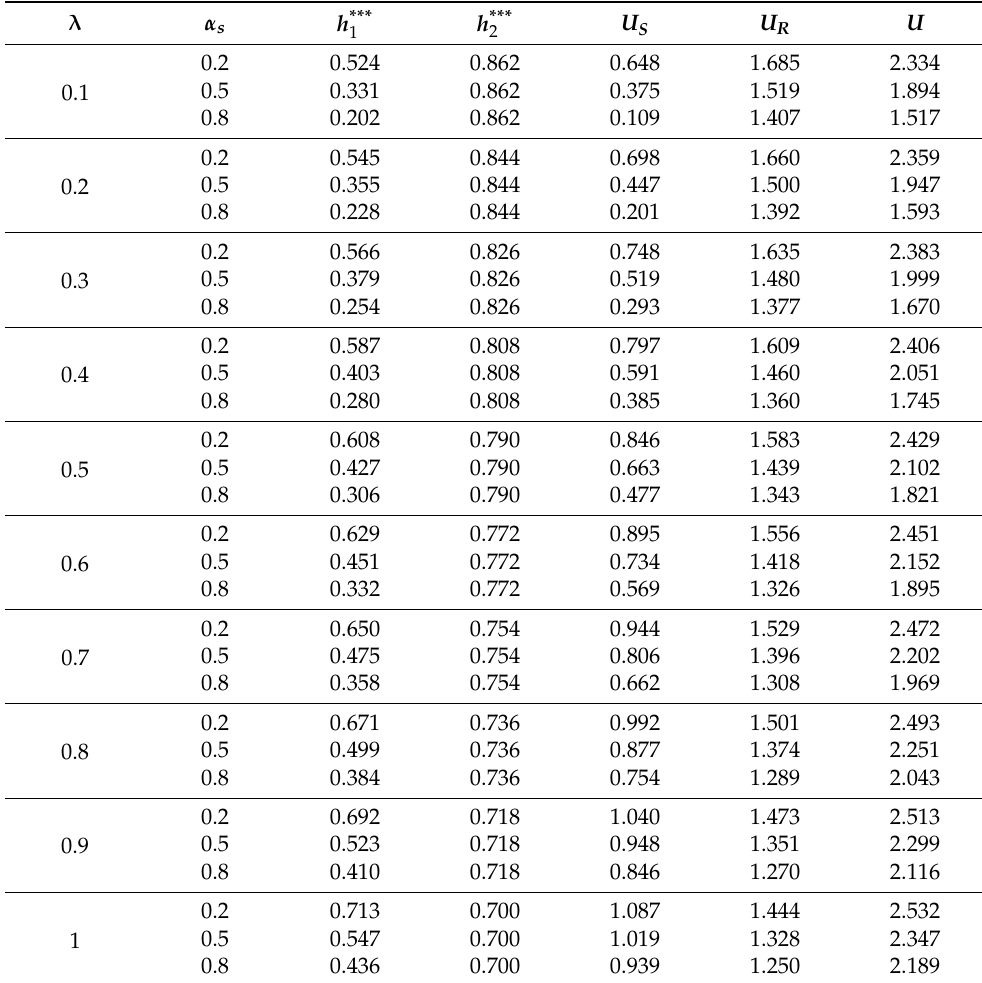
Table 2. The utility values of the retailers, distributors, and supply chains under different distribution